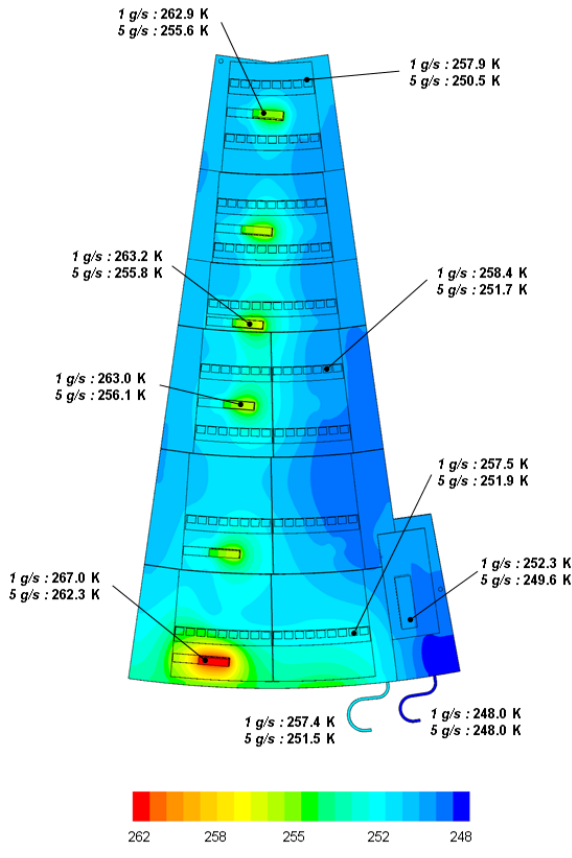
Figure 8. Surface-temperature distribution for 5 g/s.